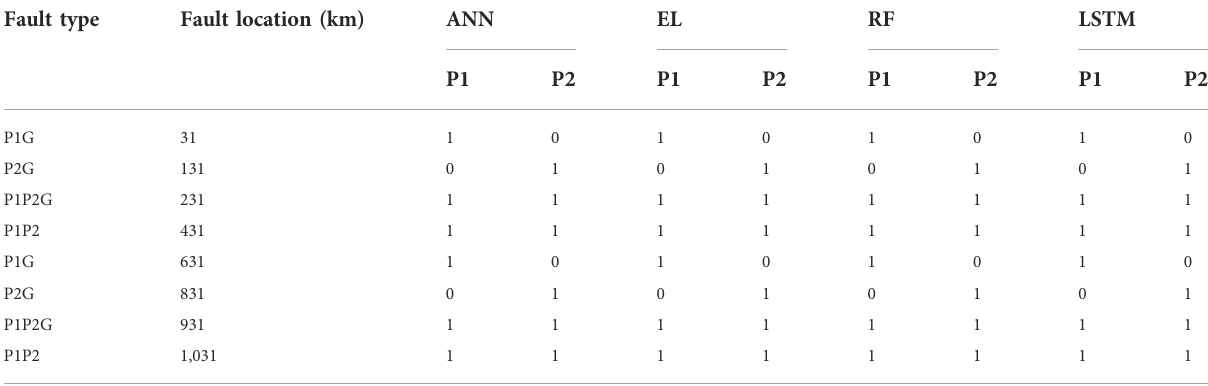
TABLE 4 Performance results during the fault pole identi fi